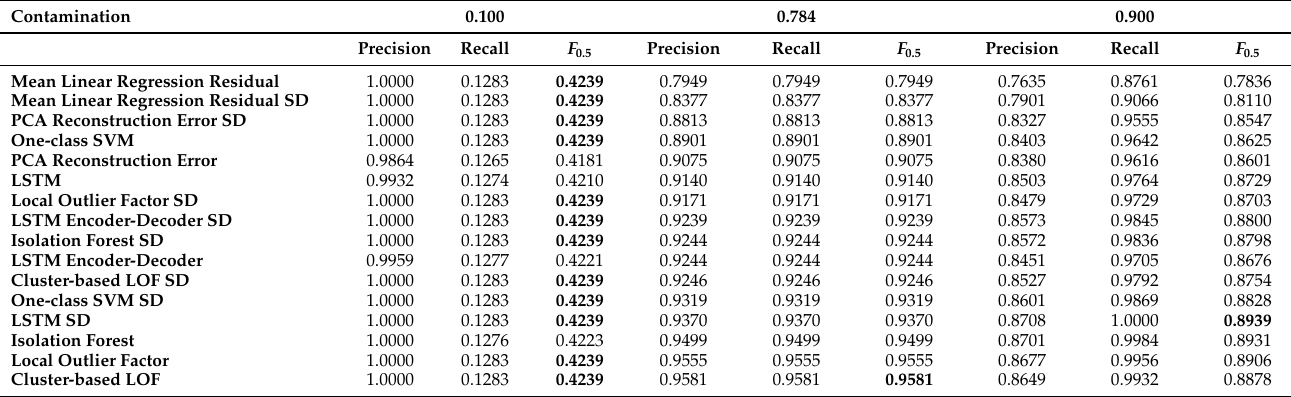
Table 3. Results for the windows dataset when thresholding using different contamination values. The use of the Seasonally- Decomposed signal instead of the original one is indicated with the letters SD.